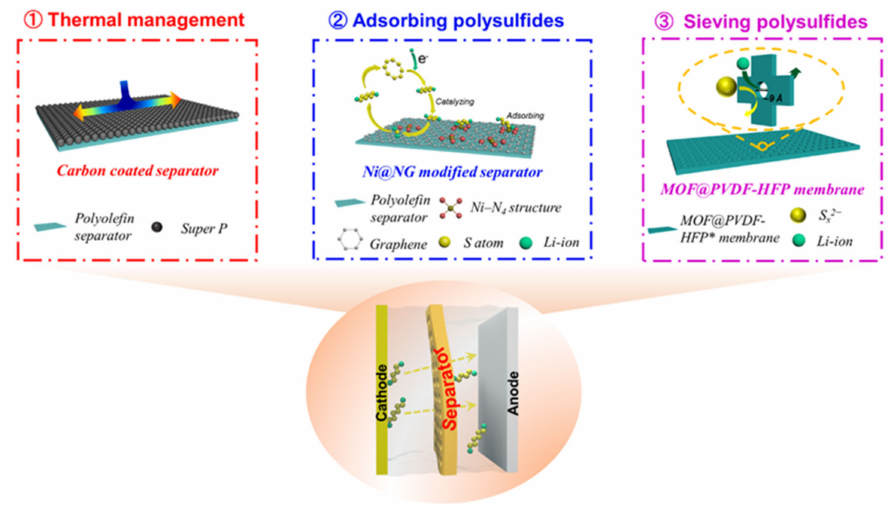
Figure 4. Separator strategies to enable Li–S pouch cells. ( 1 ) Thermal management coatings and ( 2 )polysulfiderestrictionarethe twomaincategoriesbeing pursuedfortailoringLi–S